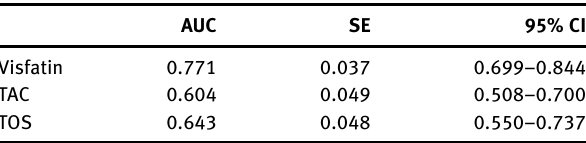
Table  : The diagnostic value of laboratory parameters and ROC analysis.